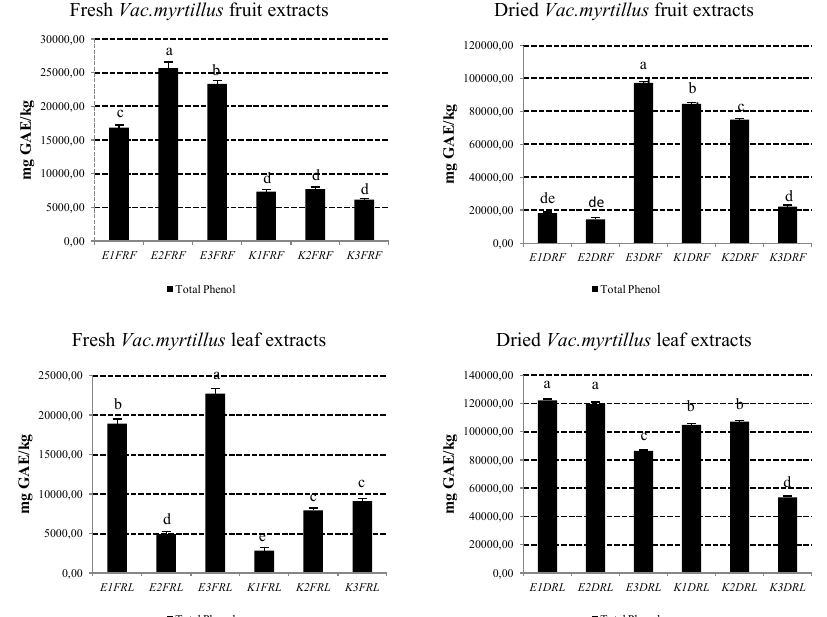
Fig. 1: Total phenolic (TP) contents (mg GAE/kg) of fresh and dried Vac. myrtillus fruit and leaf extracts ( E : Erdek, K . Kapıdağ, FR : Fresh, DR : Dried, F : Fruit, L : Leaf, 1-3: Codes of samples collected from different regions, Different letter(s) on bar indicate statistically significant differences, p <0.05)